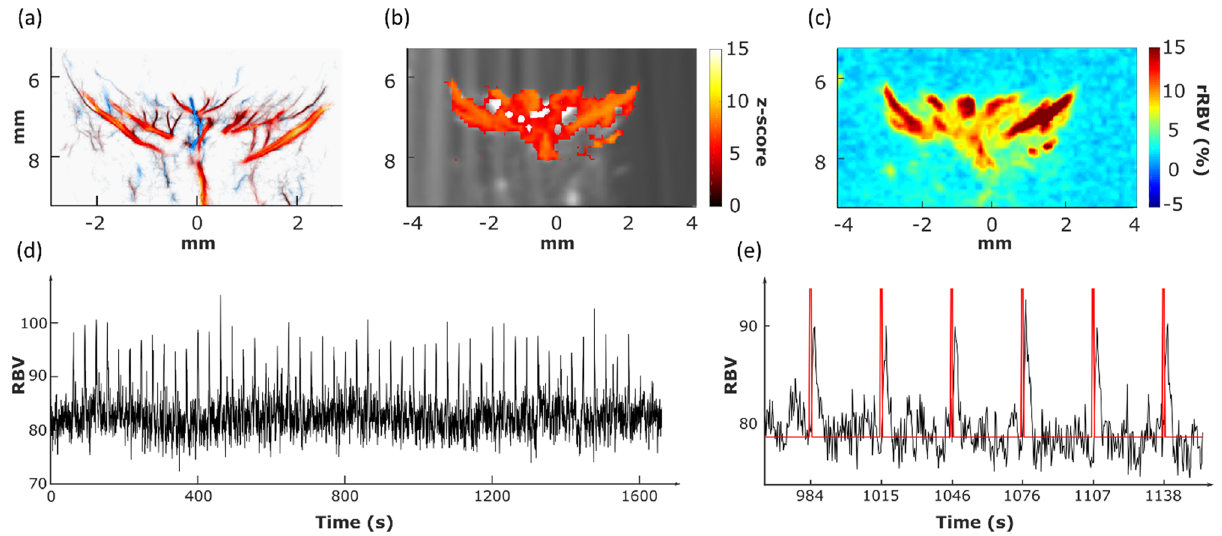
Figure 3. Neurovascular coupling in the Retinal Vascular Network ( a ) Doppler image of the rat eye. ( b ) Zscore activation map of the retina. ( c ) Delta RBV Map is showing activation percentage compared to baseline for each pixel. ( d ) Activation Map-based ROI ( p < 0.05). ( e ) ROI Mean RBV temporal Signal over the total acquisition (1660 s) comprised 50 trials. Each peak is retinal hyperemia. ( f ) Microvasculature of the retina by ULM ( g ) Zoom in the RBV temporal Signal allows better visualization of single-trial responses. The visual stimulation pattern is represented in red. ( h ) Mean trial response over the 50 trials with SEM. The visual stimulation pattern is represented in